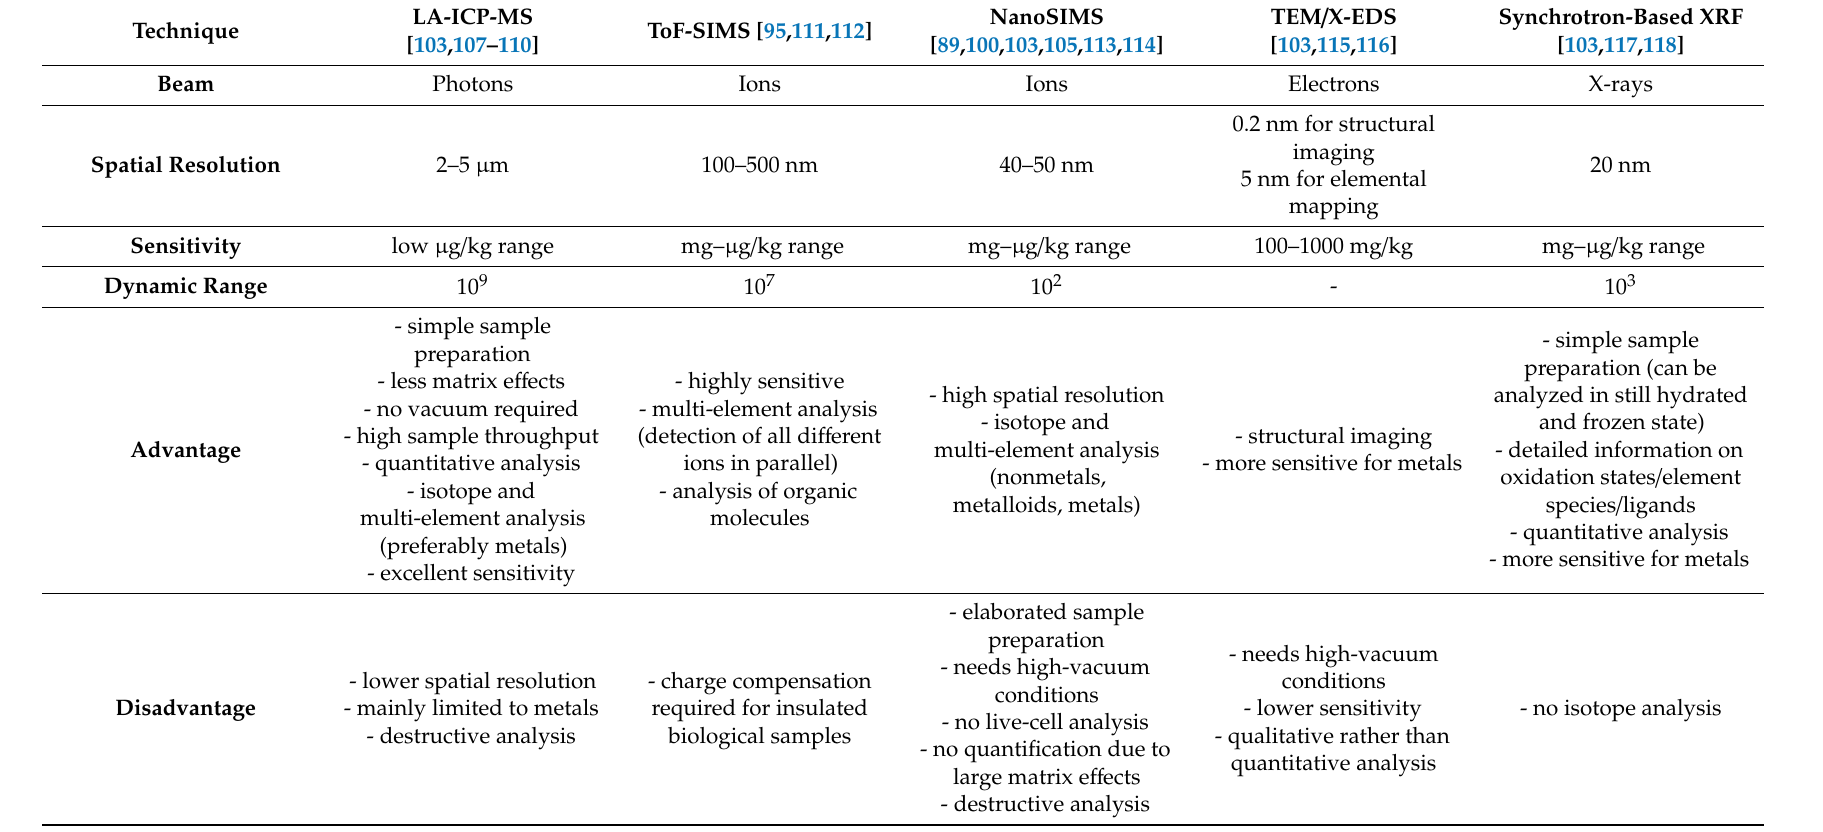
Table 1. Major analytical techniques for bioimaging and their